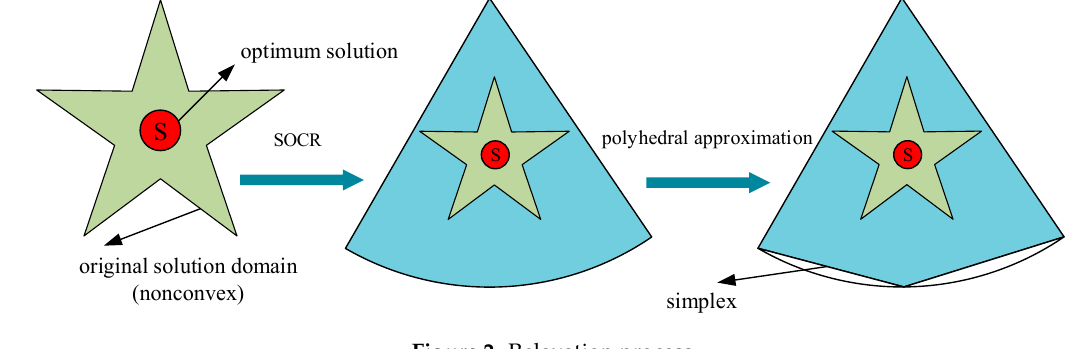
Figure 2. Relaxation process.